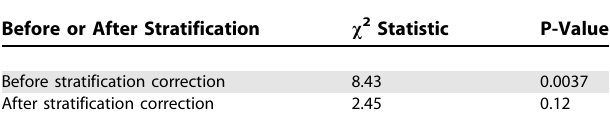
Table 3. Association Statistics between LCT Candidate Marker and Height in 368 European American Samples, before and